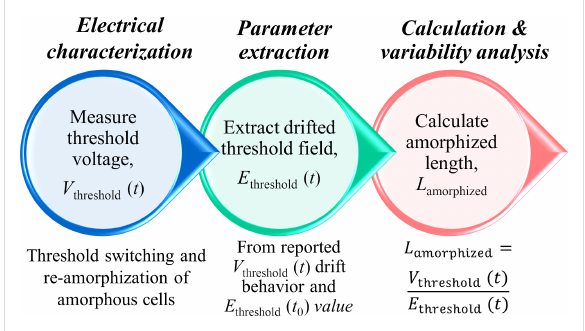
Figure 1: Schematic of the procedure used in this work for extraction of amorphized length in phase-change memory line cells.